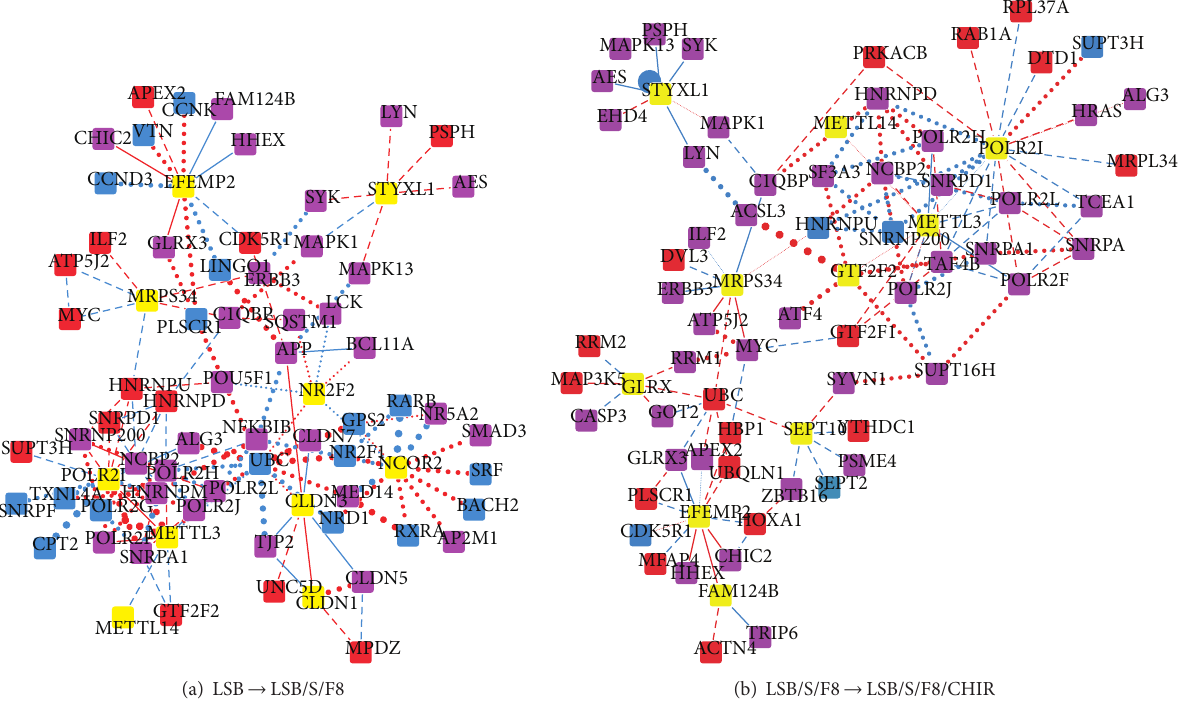
(b) LSB/S/F8 → LSB/S/F8/CHIR Figure3:InteractionactivityvariationsofthetenproteinswiththehighestrelevancescoresintheIDNsattwodifferentiationstagetransitions. (a) Interaction activity variations of the ten proteins highest in relevance score from LSB to LSB/S/F8. (b) Interaction activity variations of the ten proteins highest in relevance score from LSB/S/F8 to LSB/S/F8/CHIR. Node and edge colors and edge line styles have the same interpretation as in Figure 2. A yellow node represents a protein with a relatively high relevance score (Table 1).